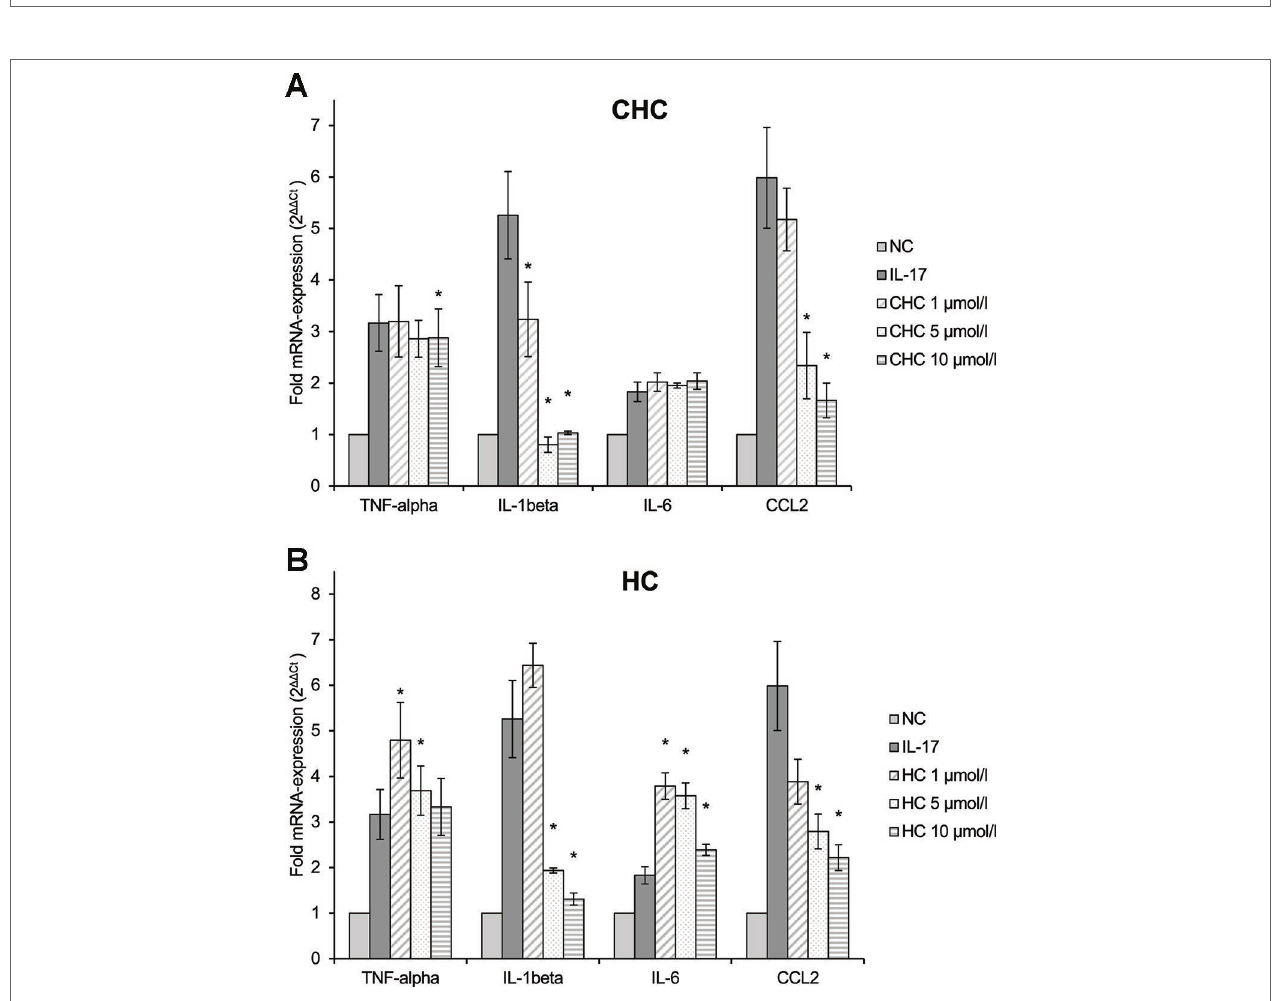
Frontiers in Pharmacology |